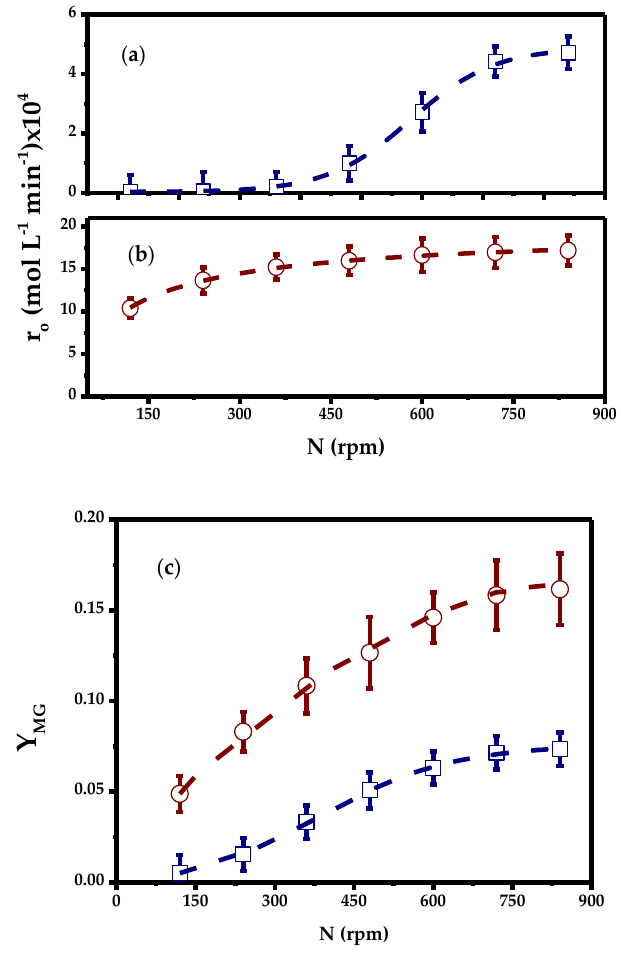
Figure 3. E ff ect of stirring speed on the initial rate of esterification at ( a ) 50 ◦ C, ( b ) 80 ◦ C, and ( c ) Figure 3. Effect of stirring speed on the initial rate of esterification at ( a ) 50 °C, ( b ) 80 °C, and ( c ) yield yield of ibuprofen monoester at 50 ◦ C ( (cid:3) ) and 80 ◦ C ( O ). Operational conditions: T = 50 and 80 ◦ C, of ibuprofen monoester at 50 °C ( □ ) and 80 °C ( Ο ). Operational conditions: T = 50 and 80 °C, C I0 = 100 C I0 = 100 g · L − 1 , C E = 30 g · L − 1 g·L −1 , C E = 30 g·L −1 .